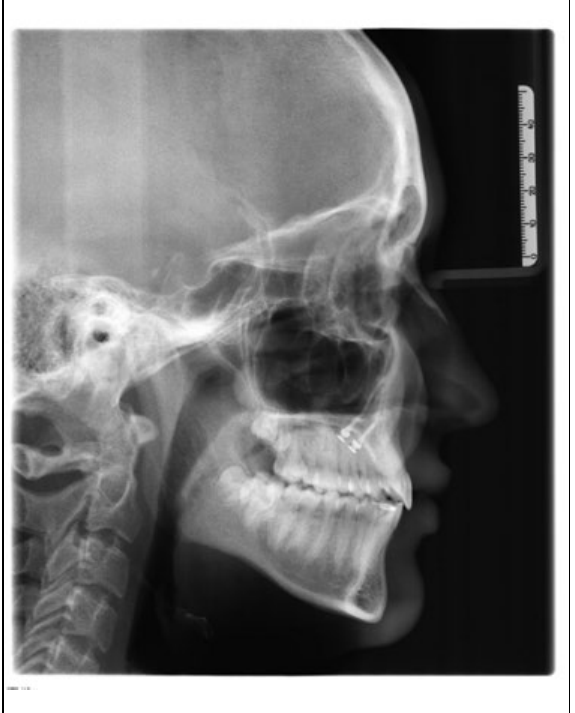
Figure 15. Panoramic radiograph following debonding and completion of active orthodontic treatment.